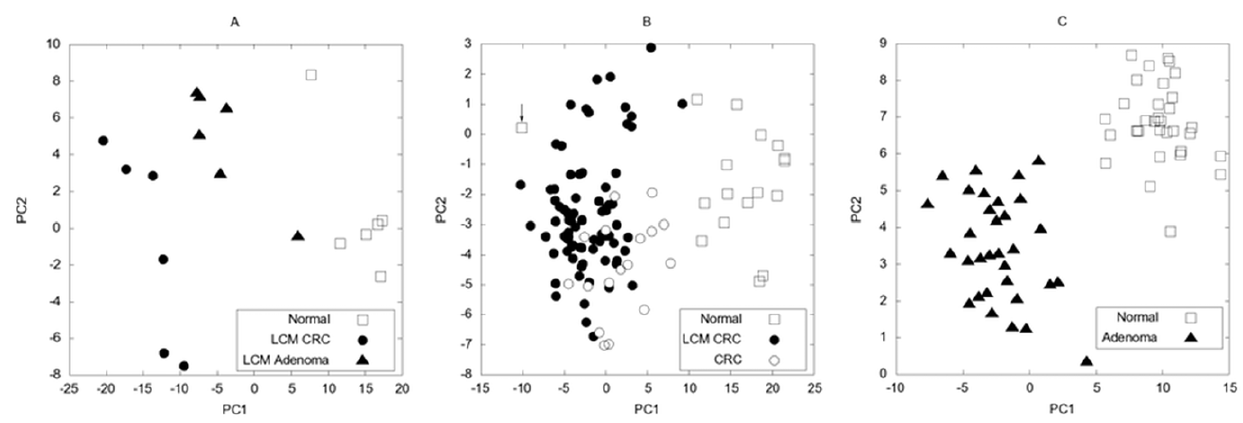
Figure 7. The first 2 principal components (PC) for our LCM (GSE15960) (A), the GSE18105 (B) and GSE8671 sample sets (C). The principal components were calculated from the log 2 -expression values of the 154 selected probe sets for the normal-CRC samples in our LCM set, and then all 3 sets were projected into the principal component coordinate space. Note that this method can be considered as an unsupervised classification, since we did not use explicitly the categories in the data analysis process. Figure 7.A shows that PC transformation separates very well the normal and LCM CRC samples and places the adenoma samples between normal and CRC samples. To validate our list of potential marker genes, we transformed the data of two other independent studies into the same PC coordinates. The two studies from the Gene Expression Omnibus microarray archive were GSE18105 with normal, CRC and LCM CRC samples and GSE8671 with normal and adenoma samples. For both sets the separation of the categories is good except for one outlier point in B marked with an arrow (see discussion in